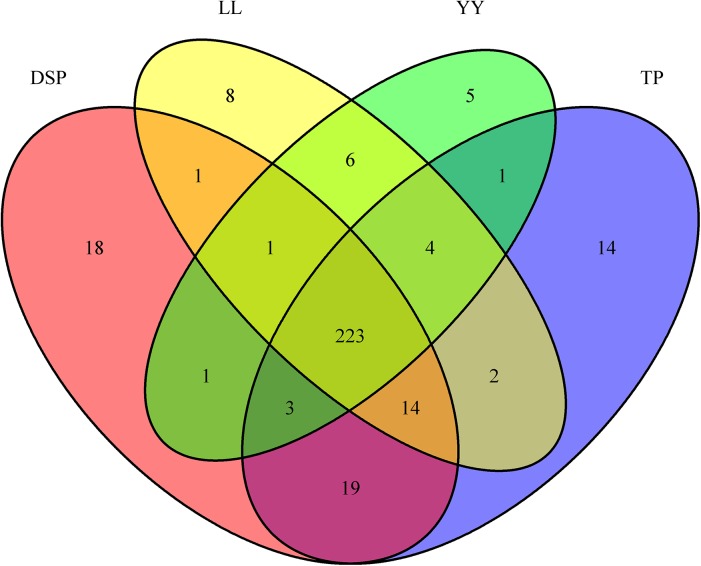
Venn diagram of expressed miRNA numbers in each sample.